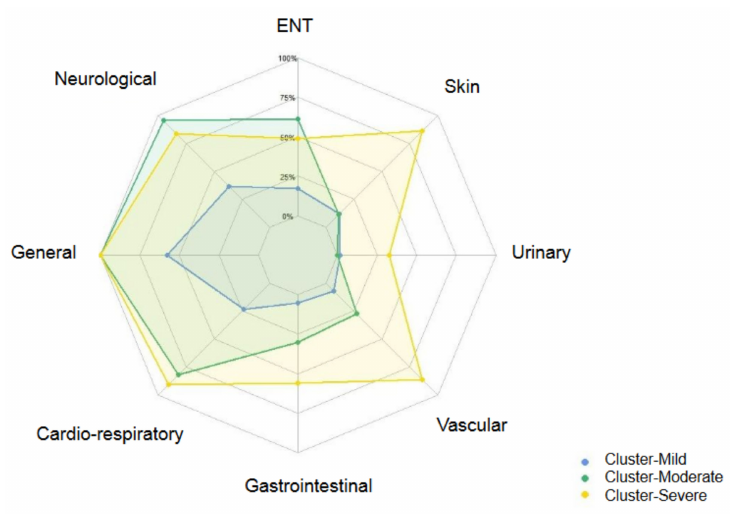
Figure 2. Distribution of Long COVID symptoms (in %) by symptom categories in the three